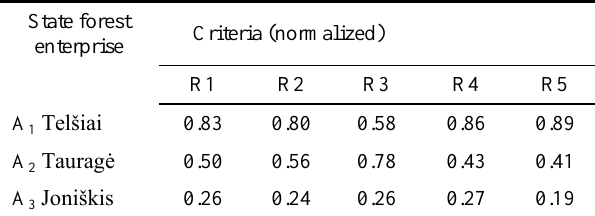
Table 7. Normalized criteria matrix for TOPSIS